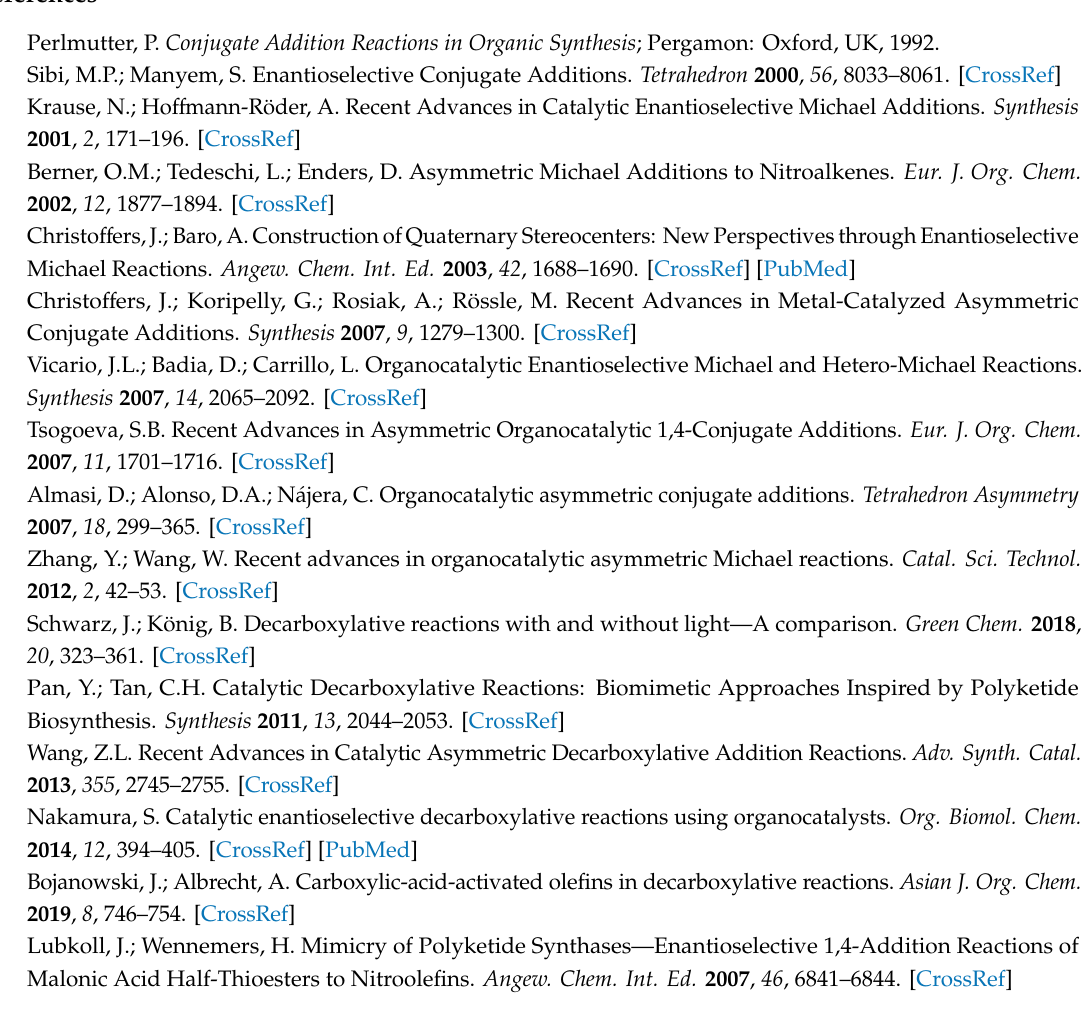
Supplementary Materials: The following are available online. Copies of 1 H and 13 C spectra of all obtained compounds. Copies of HPLC and UPC data. Crystal structure